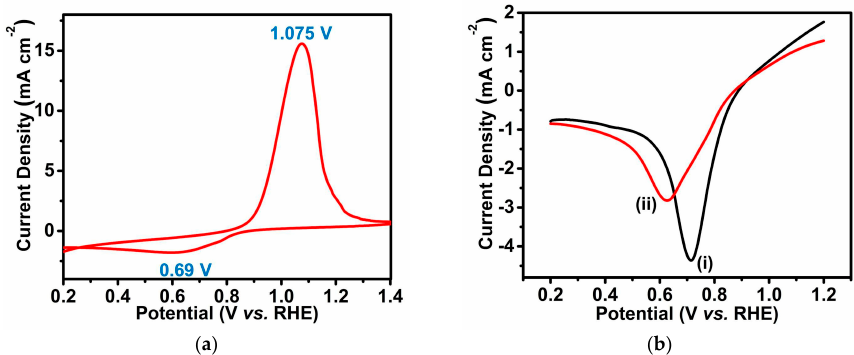
Figure 4. ( a ) CV curve of Cu@Cu 2 O core-shell nanocatalyst on glassy carbon disk electrode in O 2 -saturated 0.1 M KOH with a scan rate of 0.02 V s − 1 ; ( b ) LSV curves of Cu@Cu 2 O core-shell nanocatalyst on glassy carbon electrodes in O 2 -saturated (i) and Ar-saturated (ii) 0.1 M KOH with a scan rate of 0.02 V s − 1